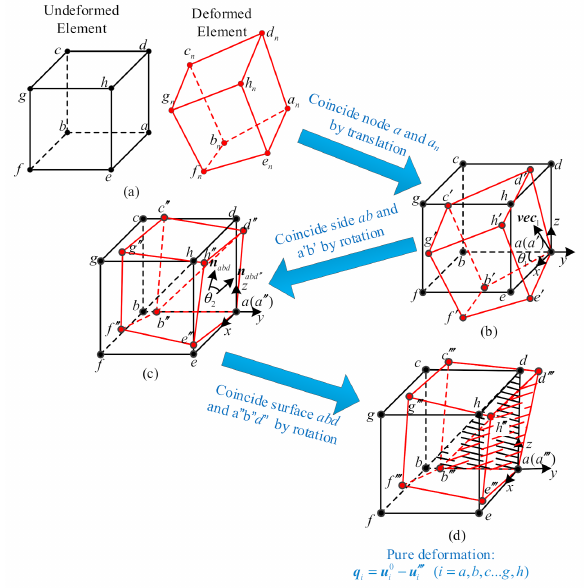
Figure 1. Solution procedure of pure nodal deformation where. ( a ) initial element and deformed element; ( b ) superpose initial element and deformed element at reference node a ; ( c ) superpose initial element and deformed element at reference side a ; ( d ) superpose initial element and deformed element at reference face